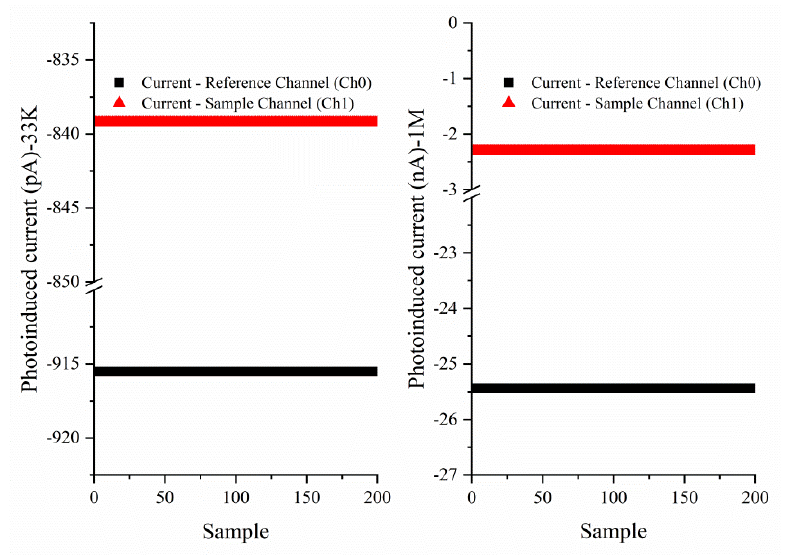
Figure 6. Front-end circuitry noise under two kinds of gain settings.